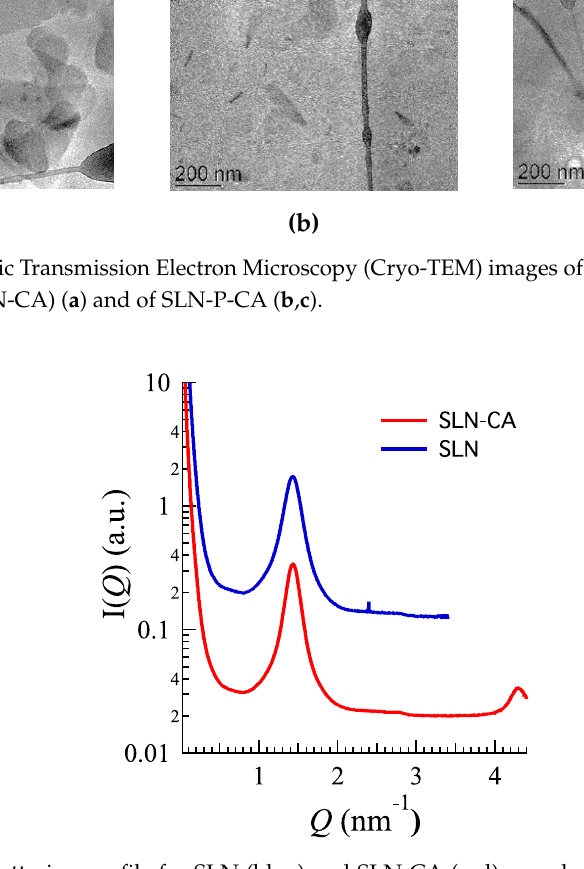
Figure 1. Cryogenic Transmission Electron Microscopy (Cryo-TEM) images of drug loaded solid lipid nanoparticles (SLN-CA)( a ) and of SLN-P-CA ( b , c ).